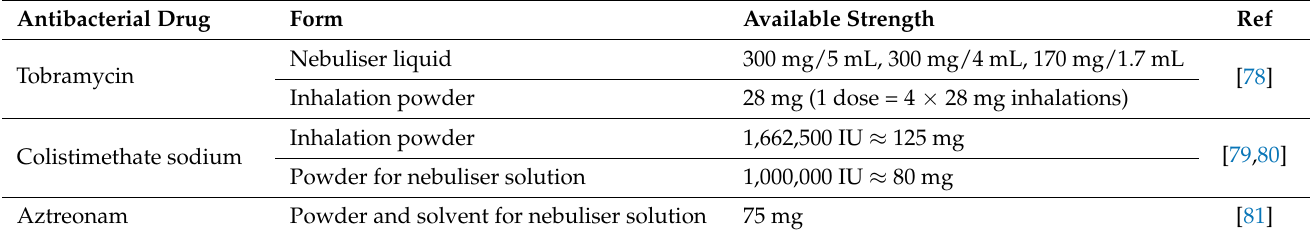
Table 5. Licensed inhaled antibacterials currently available on the